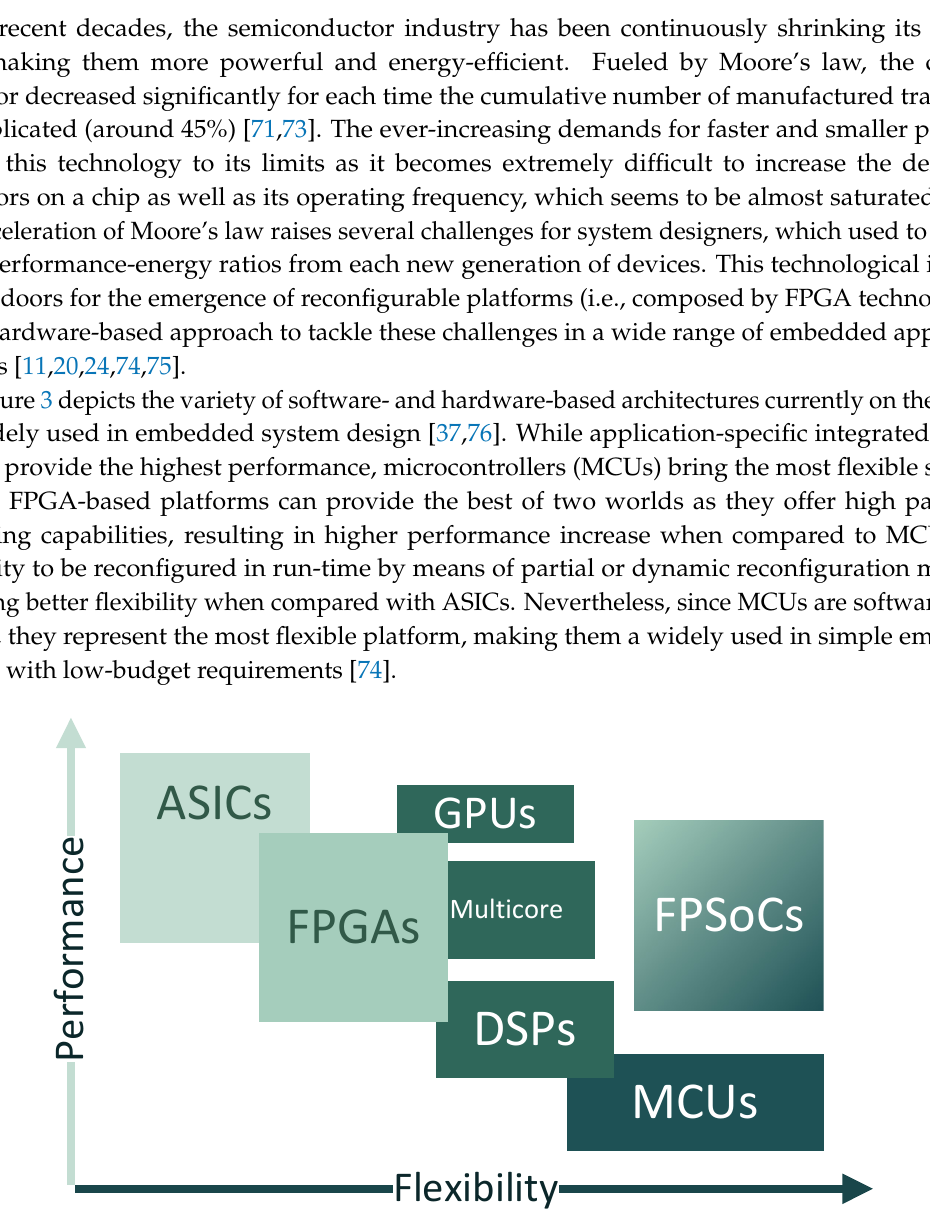
Figure 3. Performance versus flexibility of different processing